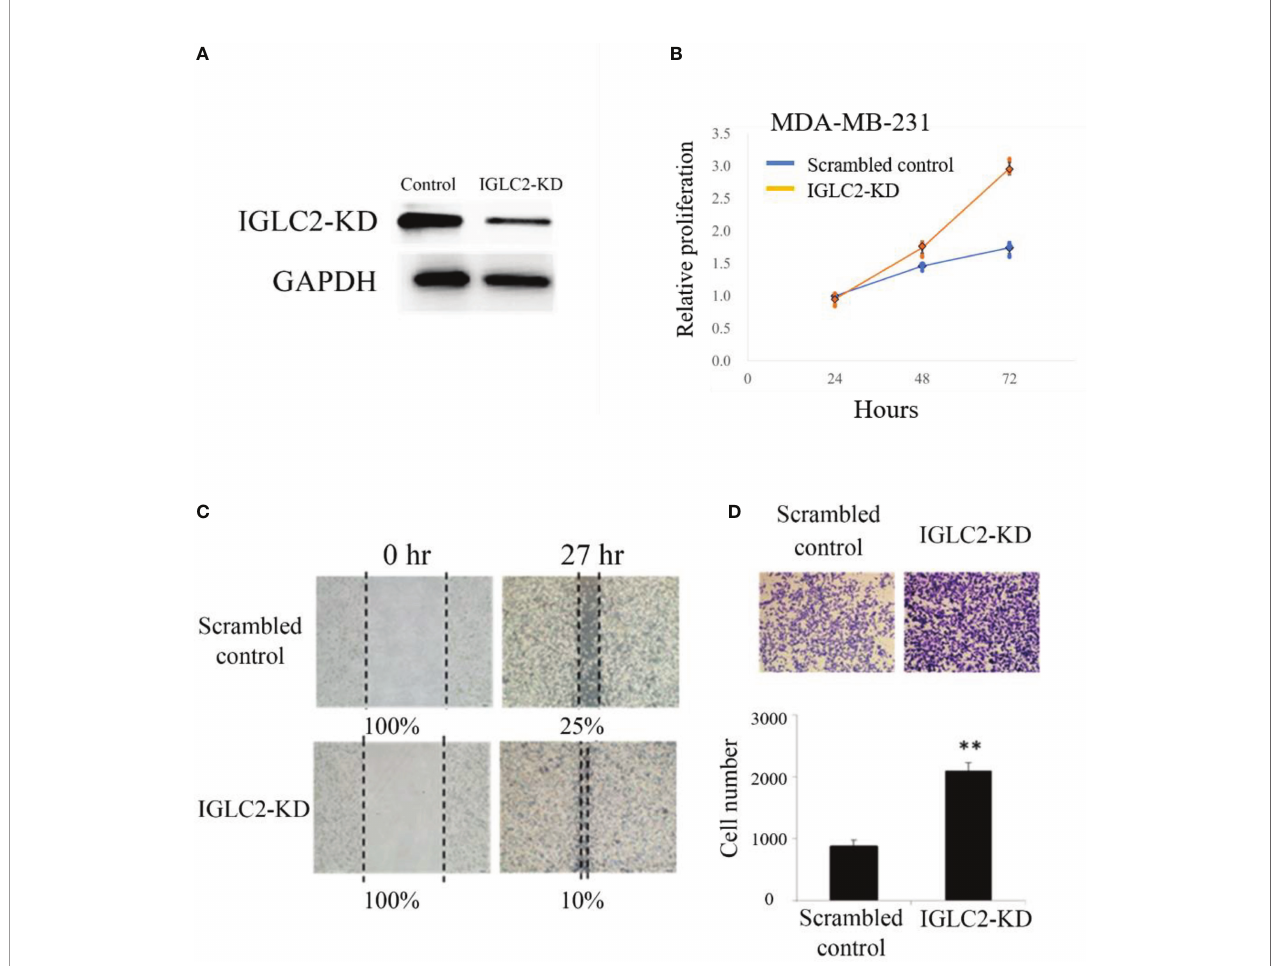
FIGURE 5 | Knockdown of expression of IGLC2 increased proliferation, migration, and healing of MDA-MB-231 cells. (A) Immunoblot analysis of IGLC2-KD in MDA- MB-231 cells. Glyceraldehyde-3-phosphate dehydrogenase was used as an internal control. (B) The proliferation ability of IGLC2-KD MDA-MB-231 cells increased compared with that of the scrambled control in the MTT assay. (C) In the wound-healing migratory assay, IGLC2-KD MDA-MB-231 cells showed a faster healing ability than the scrambled control cells. (D) The migratory ability of IGLC2-KD MDA-MB-231 cells increased compared with that of the scrambled control in the transwell cell migration assay. The MDA-MB-231 cells were dyed by crystal violet staining. Statistical analysis was performed using Mann – Whitney U test. ** P < 0.01 was considered signi fi cantly